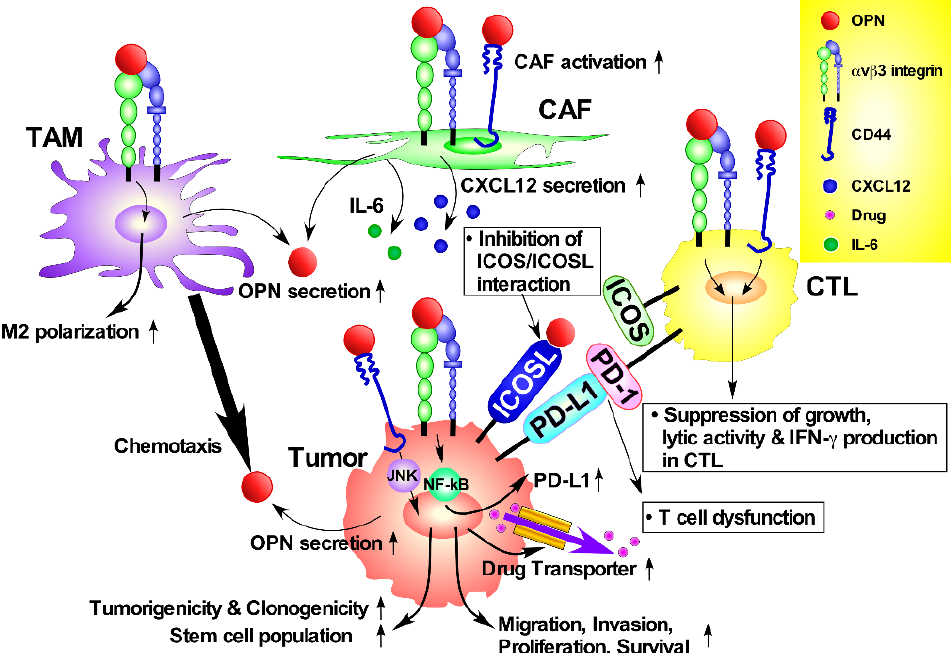
Figure 4. Regulation of tumor immunity by osteopontin (OPN) in the tumor microenvironment. In tumor cells, OPN promotes migration, invasion, proliferation, survival, tumorigenicity, clonogenicity, stem cell population, drug transporter expression, as well as OPN secretion through the integrins and CD44-mediated signaling pathways. In tumor-associated macrophages (TAMs), OPN– α v β 3 integrin engagement induces M2 polarization and OPN production. In cancer-associated fibroblasts (CAFs), OPN promotes IL-6, CXCL12, and OPN secretion through the association with α v β 3 integrin and CD44. OPN inhibits the cytotoxic T lymphocyte (CTL) response through immune checkpoint engagement via PD-L1 expression, binding to ICOSL, as well as suppression of cell proliferation, lytic activity, and IFN- γ production through α v β 3 integrin and CD44-mediated signals in CTL.